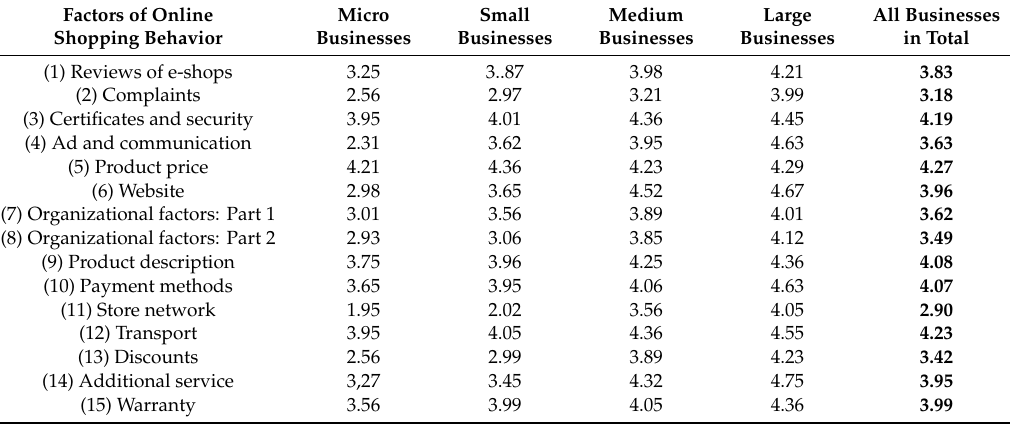
Table A1. Evaluation of the factors of online shopping behavior according to the size of the e-commerce businesses. Source: own research.